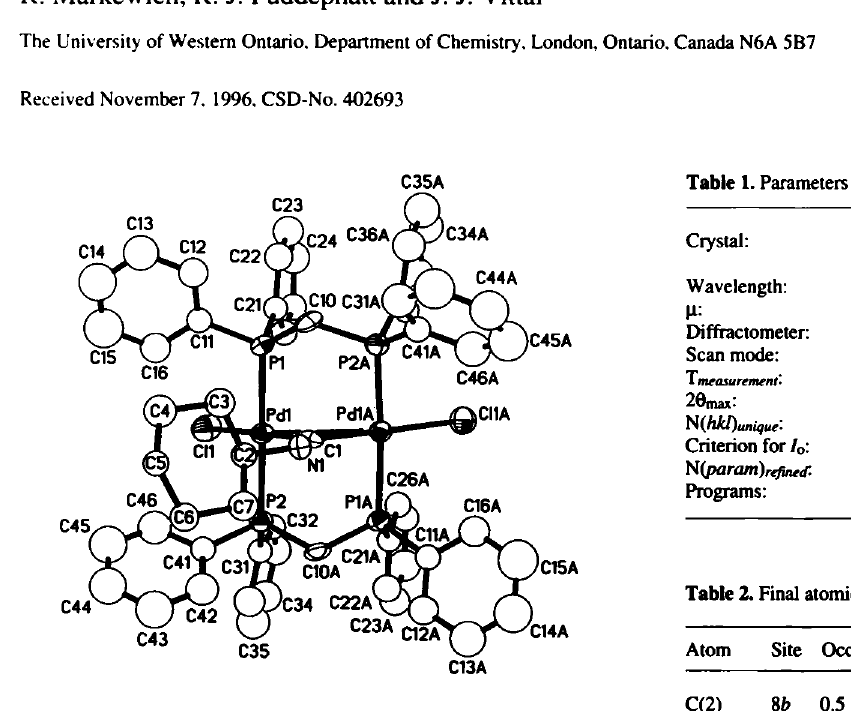
Table 1. Parameters used for the X-ray data collection